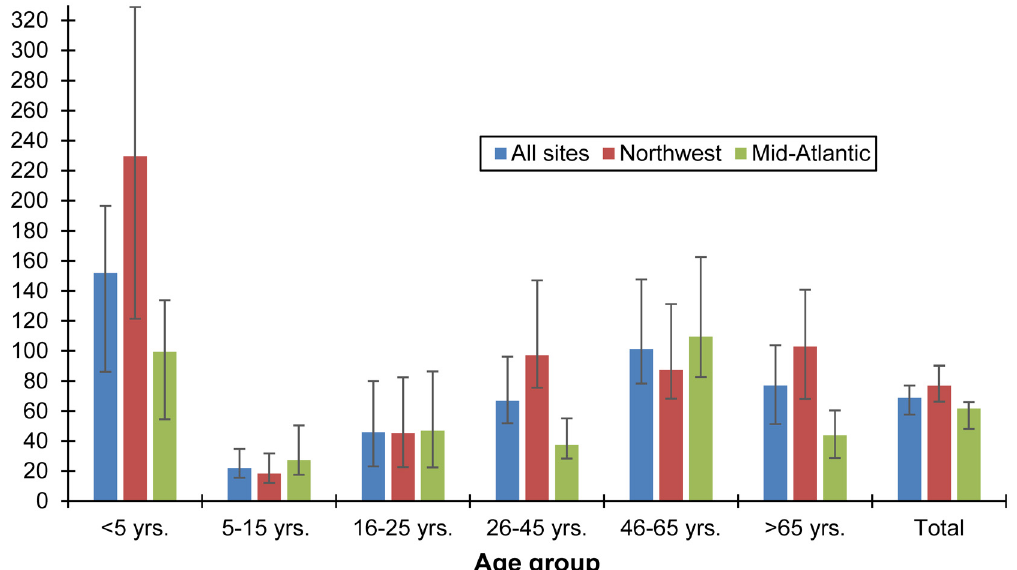
Fig 3. Estimated community incidence of norovirus AGE among outpatients in Kaiser Permanente Northwest and Mid-Atlantic Health Plans, by age group, 2012 – 2013.